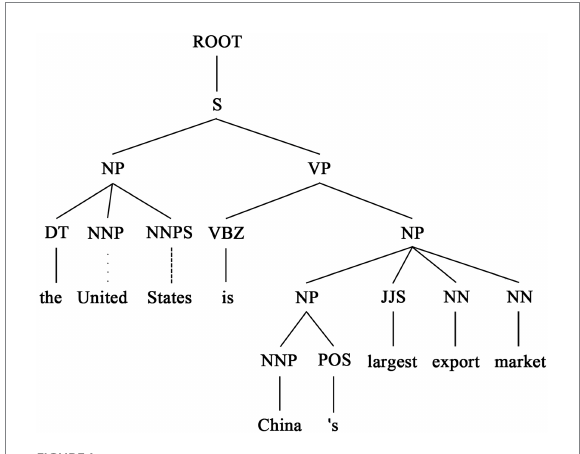
FIGURE 1 A sample of syntactic constituents (part of speech) analysis.